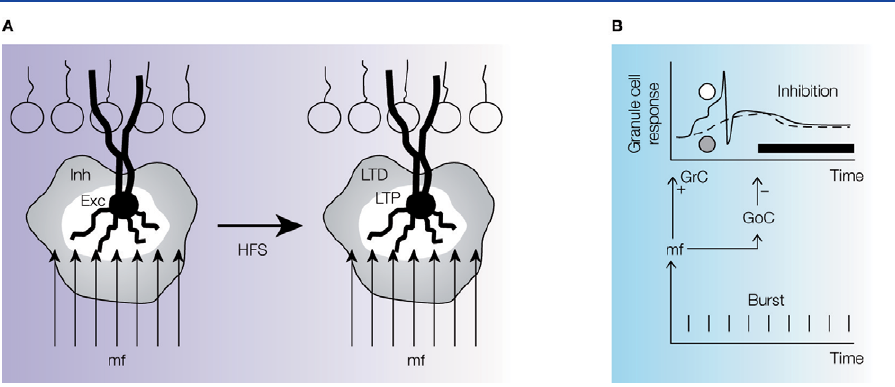
Figure 5 | Spatio-temporal transformations based on integrated regulation of timing and plasticity. This schematic reconstruction, inspired by the data reported by Mapelli and D’Angelo (2007) and Nieus et al. (2006), illustrates the role of Golgi cells in controlling spatio-temporal reconfi guration of granular layer activity and long-term synaptic plasticity at the mossy fi ber granule cell relay. (A) The center-surround organization (white-gray areas) of excitation and inhibition determines a biphasic response to high-frequency stimulation trains in the mossy fi bers, such that the core tends to generate LTP and the surround to generate LTD. The Golgi cell is shown in black. (B) The picture illustrates the expected effect of a mossy fi ber burst (bottom) entering into the granular layer. If one assumes that LTP and LTD have been distributed in center-surround as shown in (A) , then the granular layer output will occur with delays that are different for the granule cells in the two regions. Actually, the center and the surround will act as differential delay lines due to the fact that LTP anticipates and LTD delays granule cell output responses to mossy fi ber bursts. The top graph shows the idealized output response for two granule cells (solid line for a granule cell with LTP, dashed line for a granule cell with LTD). The regulation of delays occurs across the inhibitory window set by the Golgi cell (black line), which is also coactivated by the mossy fi ber burst but inhibits granule cells with a delay caused by its own excitation time and the additional synapse inbetween. Mossy fi ber–granule cell LTP effectively anticipates spike generation before the arrival of Golgi cell inhibition. Conversely, mossy fi ber–granule cell LTD slows down membrane potential growth to the point that spikes are not generated before the arrival of Golgi cell inhibition, which will further slow down depolarization eventually preventing any spike generation. Thus, the Golgi cell in combination with mossy fi ber–granule cell plasticity endows the granular layer with the properties of a spatio-temporal fi